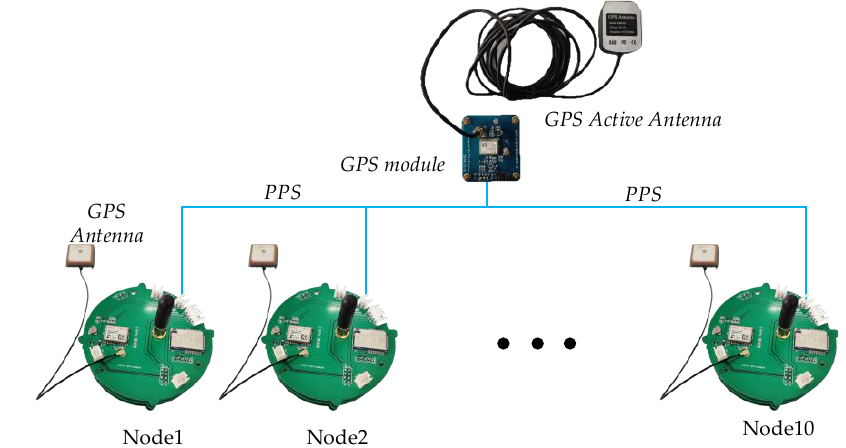
Figure 12. The schematic of the time synchronization stability test.